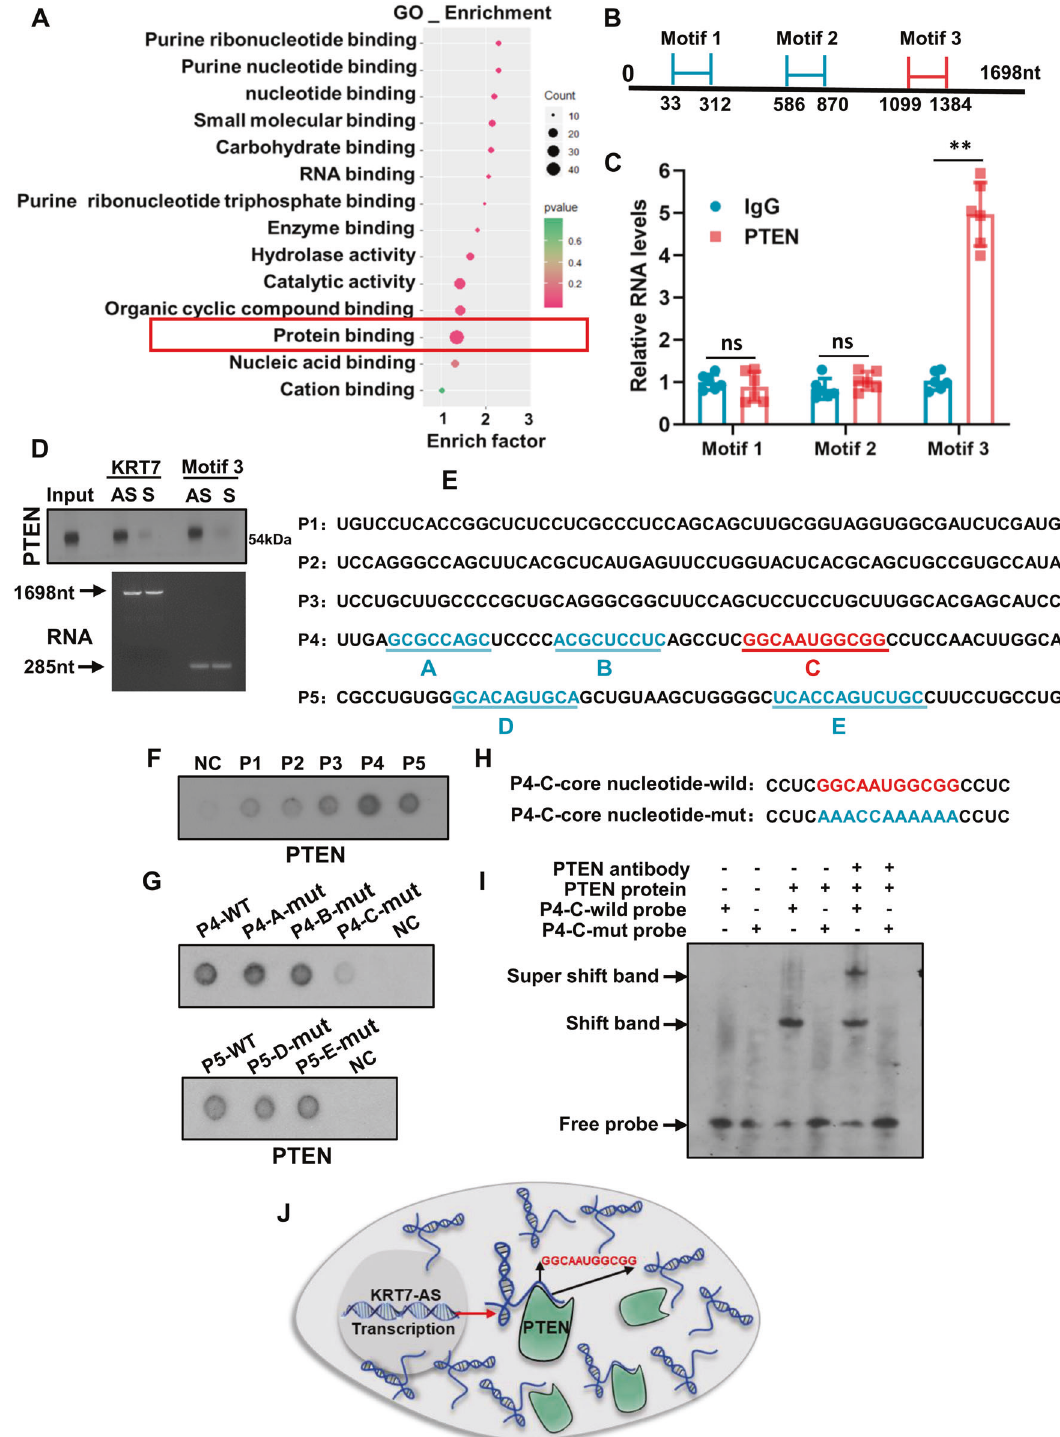
Fig. 8 KRT7-AS directly binds to PTEN and stabilizes the protein in lung cancer cells. GO analysis indicated that KRT7-AS possesses putative protein-binding motifs with the highest count as shown in a red frame ( A ). CatRAPID analysis showed that KRT7-AS has three putative motifs that potentially bind to PTEN protein ( B ). RIP assay showed that the motif 3 of KRT7-AS bound to PTEN protein ( C ), RNA pulldown assay indicated that the anti-sense KRT7-AS (full length or motif 3), but not the sense KRT7-AS (full length or motif 3), bound to PTEN protein directly ( D ). CatRAPID further predicted that there are fi ve sub-fragments ( A – E ) in the motif 3 ( E ). Dot blot showed that the binding of fragments P4 and P5 with PTEN protein was stronger than the other 3 fragments ( F ). Dot blot showed that the P4 mutation (P4-C-mut) lost its ability for binding to PTEN protein ( G , H ). EMSA assay showed that wild type of the P4-C sub-fragment GGCAAUGGCGG bound to PTEN protein directly, whereas mutant P4-C lost the binding capability ( I ). Schematic fi gure showed the binding of KRT7-AS to PTEN protein ( J ). Data are shown as mean ± SD of three independent replicates. ** P <